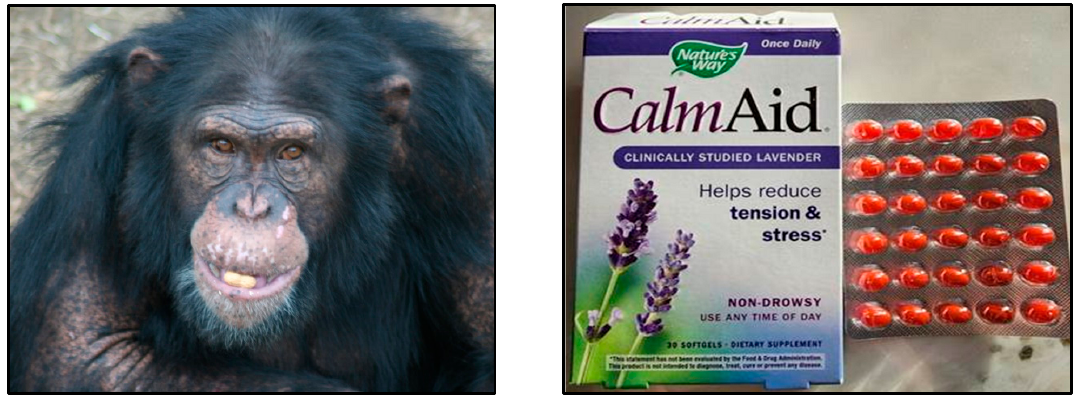
Figure 1. Male chimpanzee ( Pan troglodytes ), TO, who received oral lavender capsules and the CalmAid ® , softgel capsules.